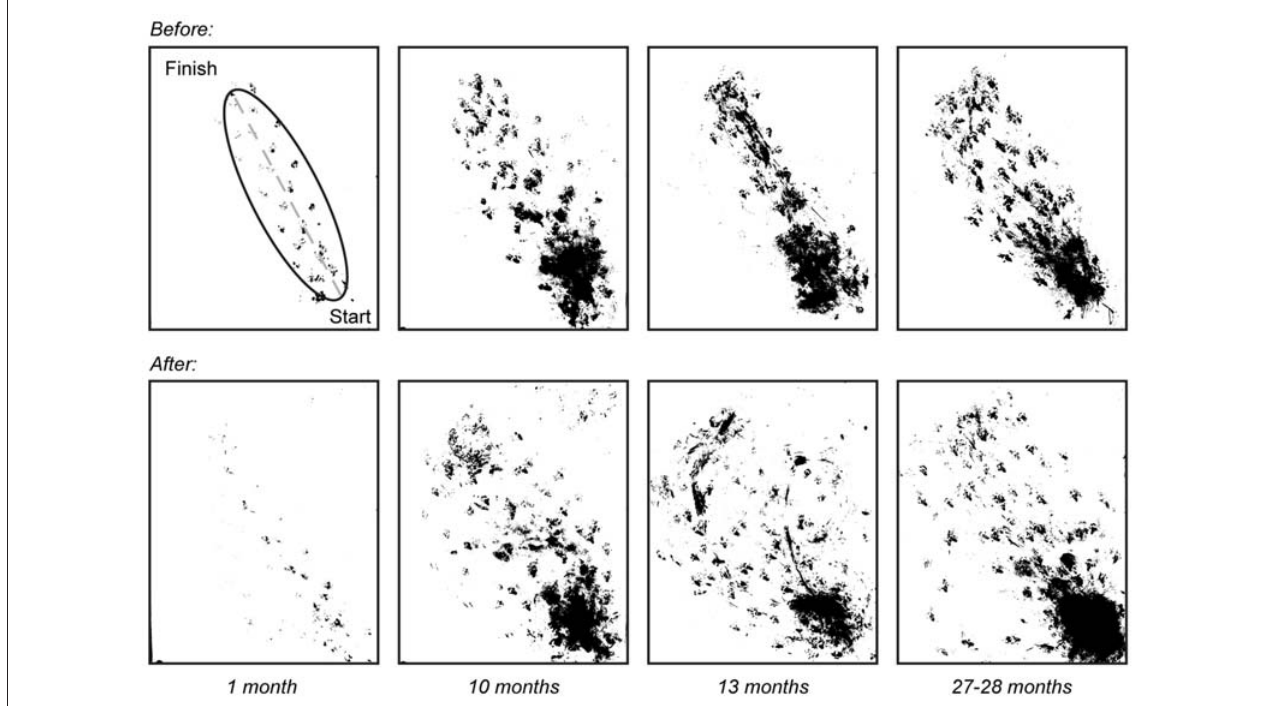
FIGURE 4 | Walking trajectory before and after vestibular stimulus . Photos of walking patterns obtained for mice of ages 1 ( n = 3), 10 ( n = 7), 13 ( n = 6) and 27–28 ( n = 8) months were overlaid before and after the vestibular stimulus. An ellipse was fitted to the walking paths of each mouse and the length of the minor axis was measured and used to quantify changes in walking trajectory with